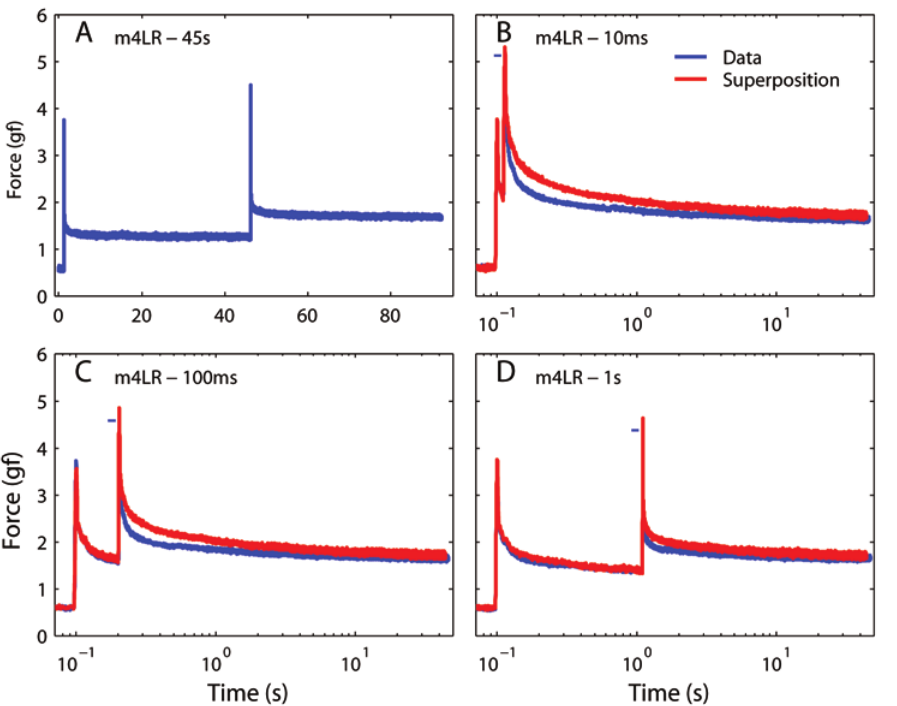
Figure 12. Testing the superposition hypothesis in muscle at short lengths. Same as Fig. 11, but in a different muscle and at the low end of the elongation range (notice the much smaller forces). Superposition does not hold at short lengths